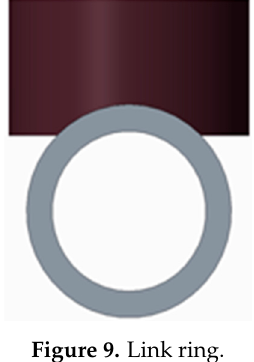
Figure 9. Link ring.